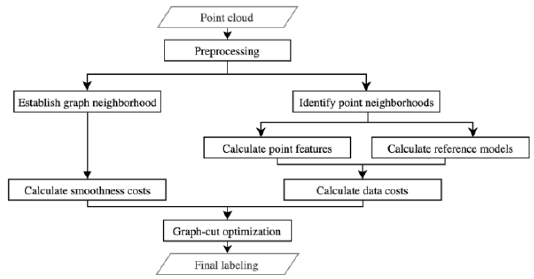
Figure 1. Workflow for min-cut based semantic point labeling from airborne lidar